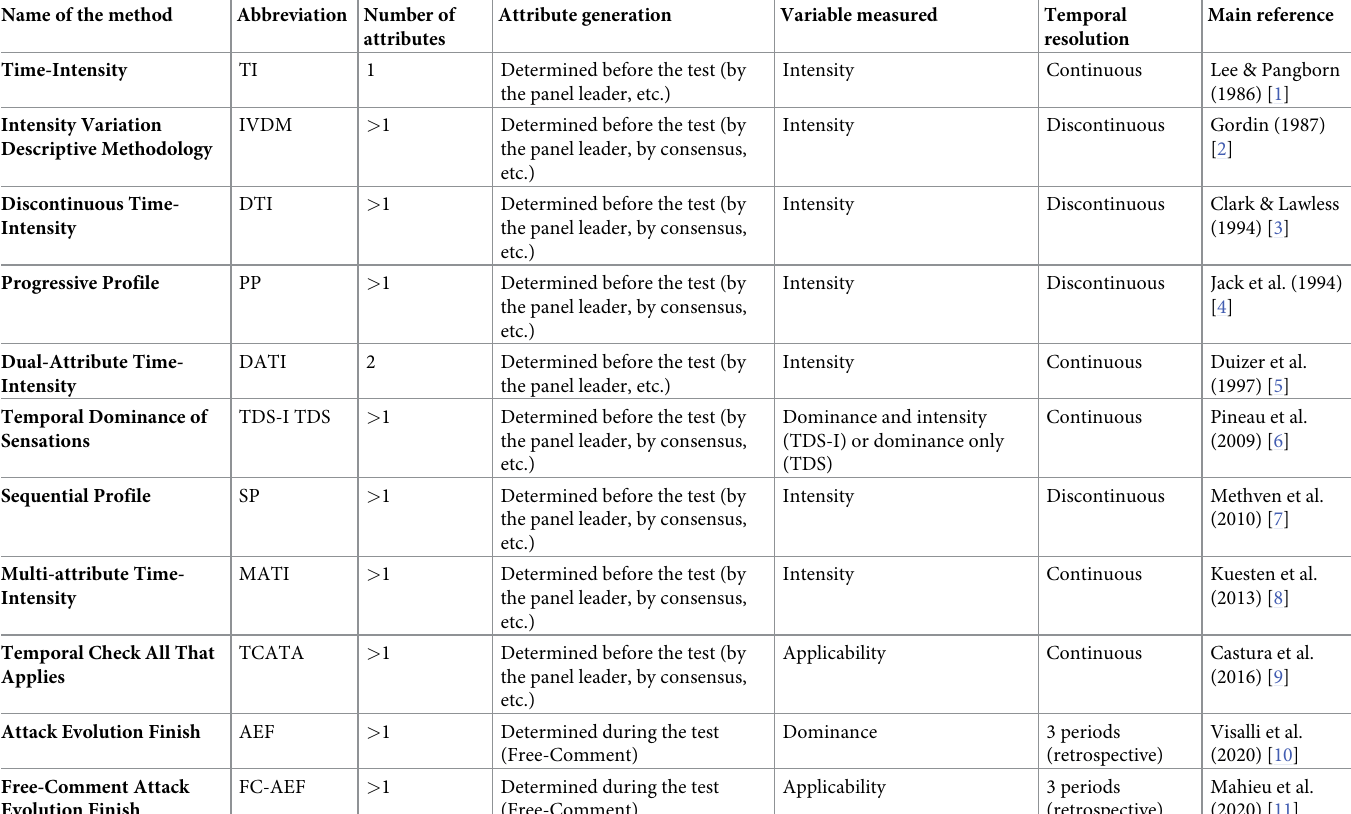
Table 1. Main sensory descriptive temporal methods published in peer-reviewed articles, in chronological